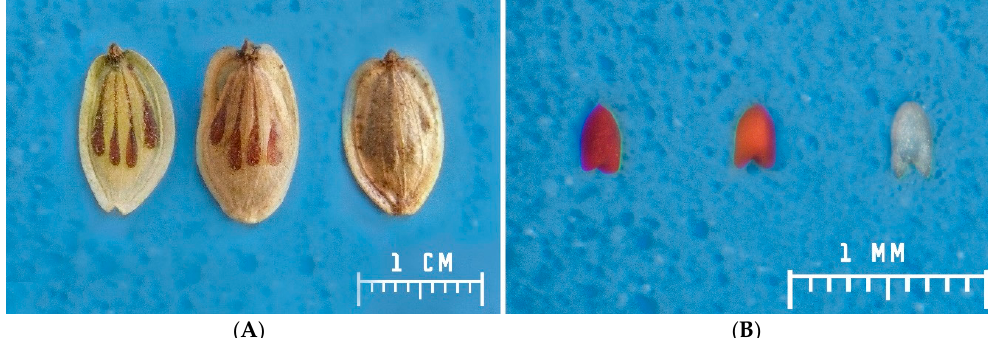
Figure 1. ( A ): Heracleum mantegazzianum seeds, harvested 2 weeks (early), 5 weeks (intermediate), 8 weeks (late) after flowering. ( B ): Embryos stained with tetrazolium chloride for different viability categories: viable (red), damaged (pink), dead (white).